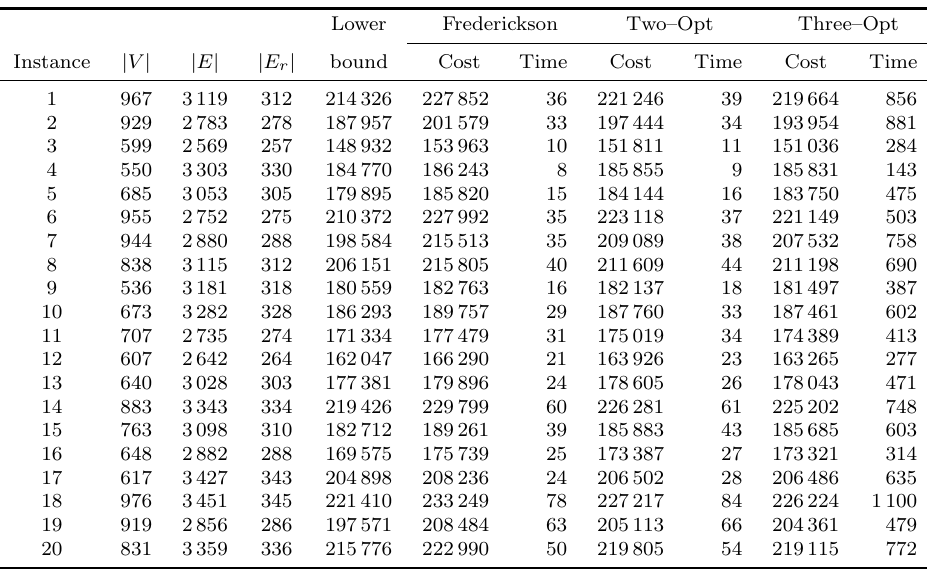
Table 2: Test results for two new RPP data sets, one consisting of Euclidean edge weights, and the other with random edge weights. Execution times are measured in seconds and were achieved on an Intel Pentium IV processor (2.8 GHz) with 512 Mb